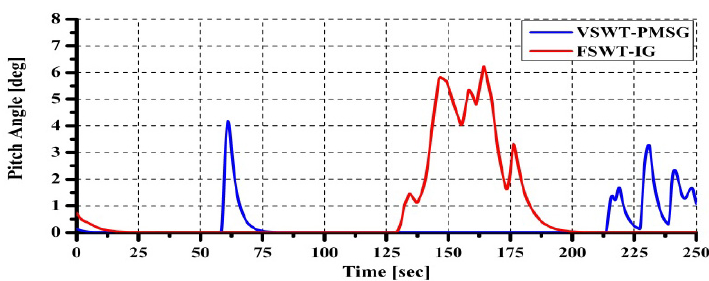
Figure 31. Pitch Angle of wind turbines.